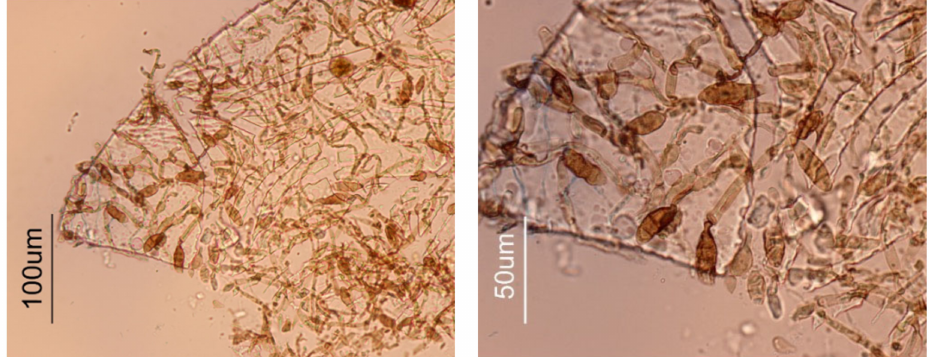
Figure 3. Optical microscope images (brightfield) of a sample collected from the inside of the mushroom hat, at lower ( left ) and higher ( right )